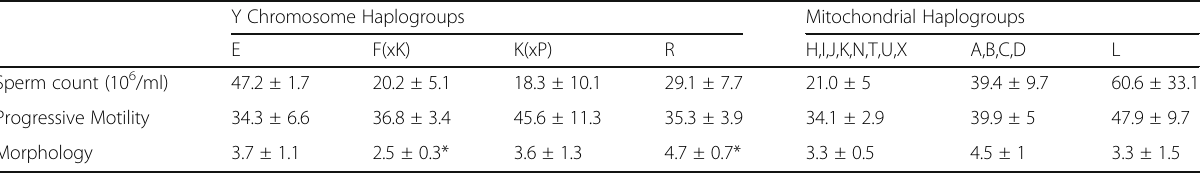
Table 5 Mean ± standard error of sperm characteristics in infertile men Y Chromosome